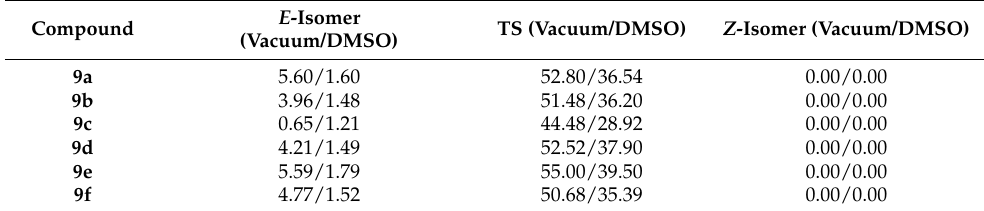
Table 2. Relative energy values for the E- , Z- , and TS forms of enamines 9a–f at the B3LYP/6- 311++G(d) level of theory. The energies of the Z-isomers were minimal. All other energies are relative to the corresponding values of the Z-isomers. Compound